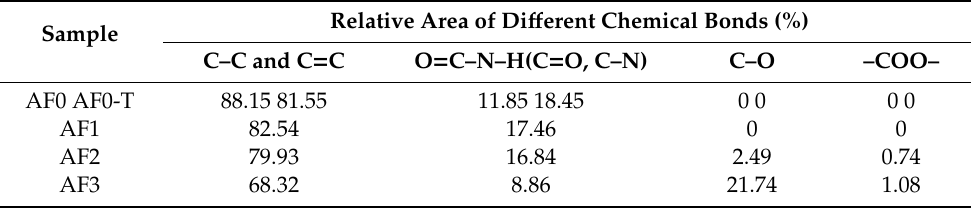
Table 3. Results of deconvolution of C 1s for aramid fiber before and after